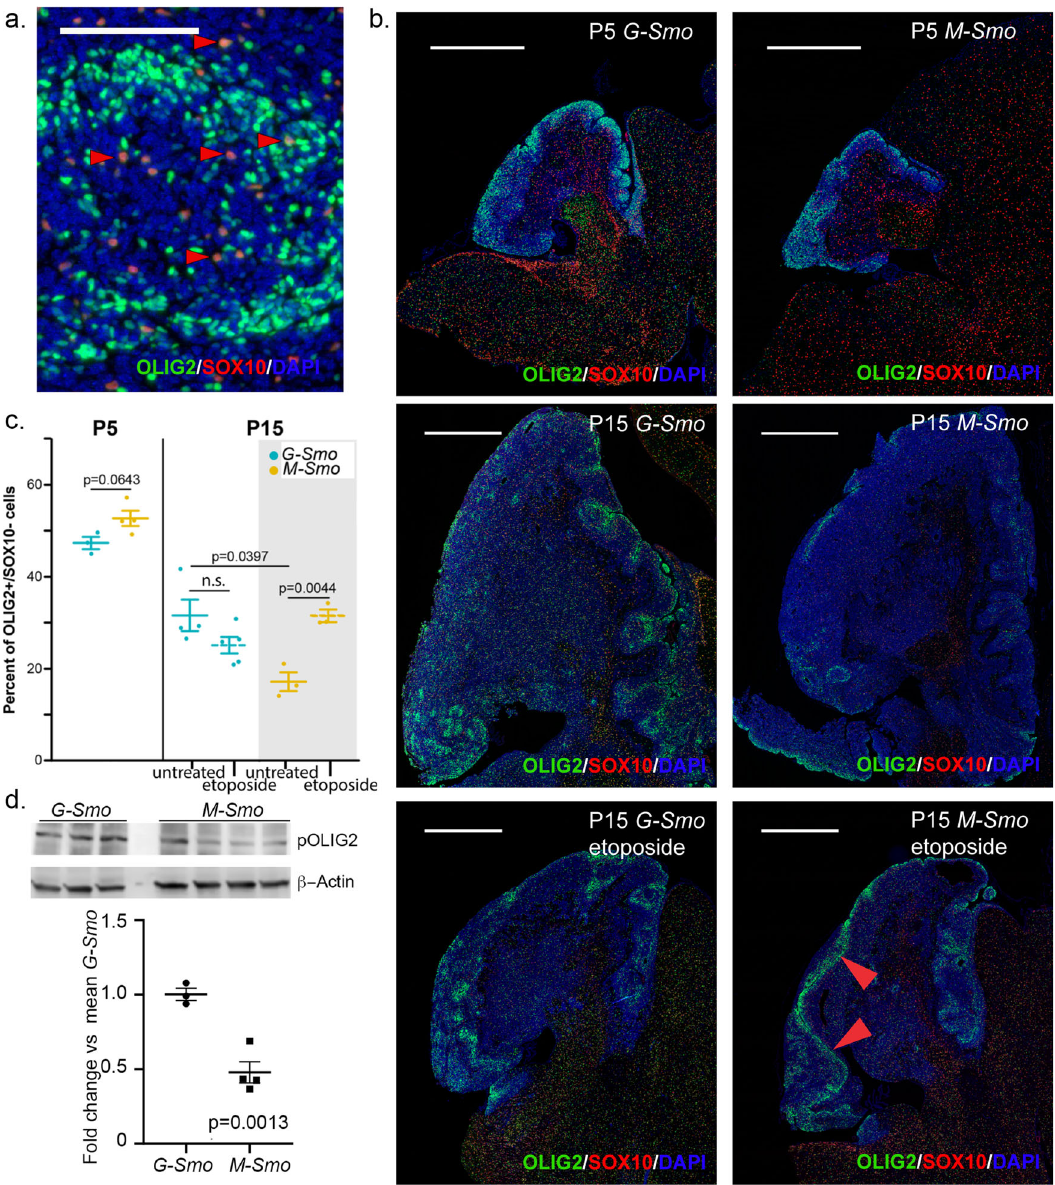
Fig. 3 OLIG2 + stem cells decline more rapidly in M-Smo compared to G-Smo tumors. a Representative higher magni fi cation images of OLIG2/SOX10 IHC on a G-Smo tumor, showing OLIG2 + /SOX10 + oligodendrocytes (arrowheads highlight examples) and OLIG2 + /SOX10 − tumor stem cells. b Representative lower magni fi cation images of OLIG2/SOX10 IHC on sagittal sections from mice of the indicated age, genotype, and treatment. Arrowheads highlight a perivascular region. Scale bars = 100 µ m in a and 1 mm in b . c Quantitative comparison of OLIG2 + /SOX10 − populations in G-Smo and M-Smo tumors. d Western blots of replicate G-Smo and M-Smo tumors, showing pOLIG2 and β -Actin. Quanti fi cation shows pOLIG2 signal, normalized to β -Actin, expressed as fold change relative to mean G-Smo value. In graphs in c and d , Student ’ s t -test was used to make pairwise comparisons, dots represent values for individual replicates, bars indicate the means and whiskers indicate the